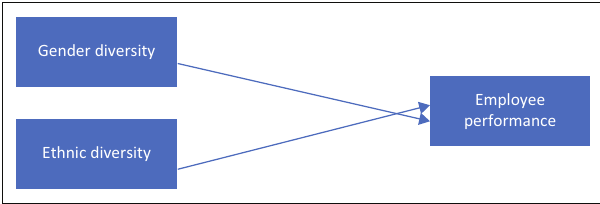
FIGURE 1: The relationship between gender diversity, ethnicity diversity and employee